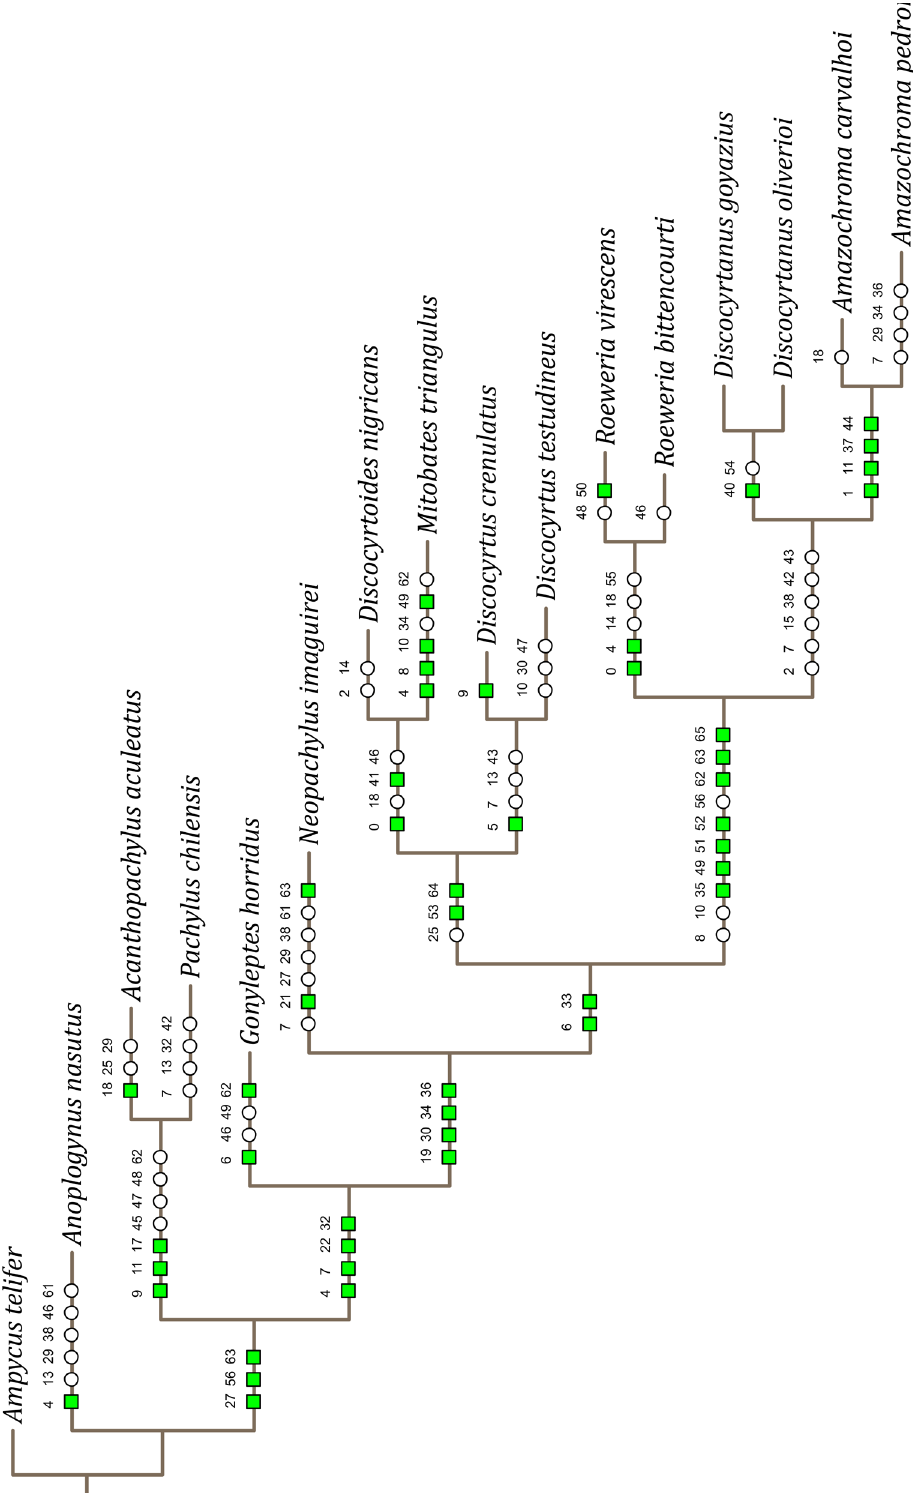
Fig. 3. Cladogram depicting proposed external and internal phylogenetic relationships of Roeweriinae subfam. nov., with unambiguous synapomorphies for each clade mapped. This is the single tree obtained by TNT. Small numbers above symbols are the numbers of the characters. Green squares = non- homoplastic synapomorphies; white circles = homoplastic